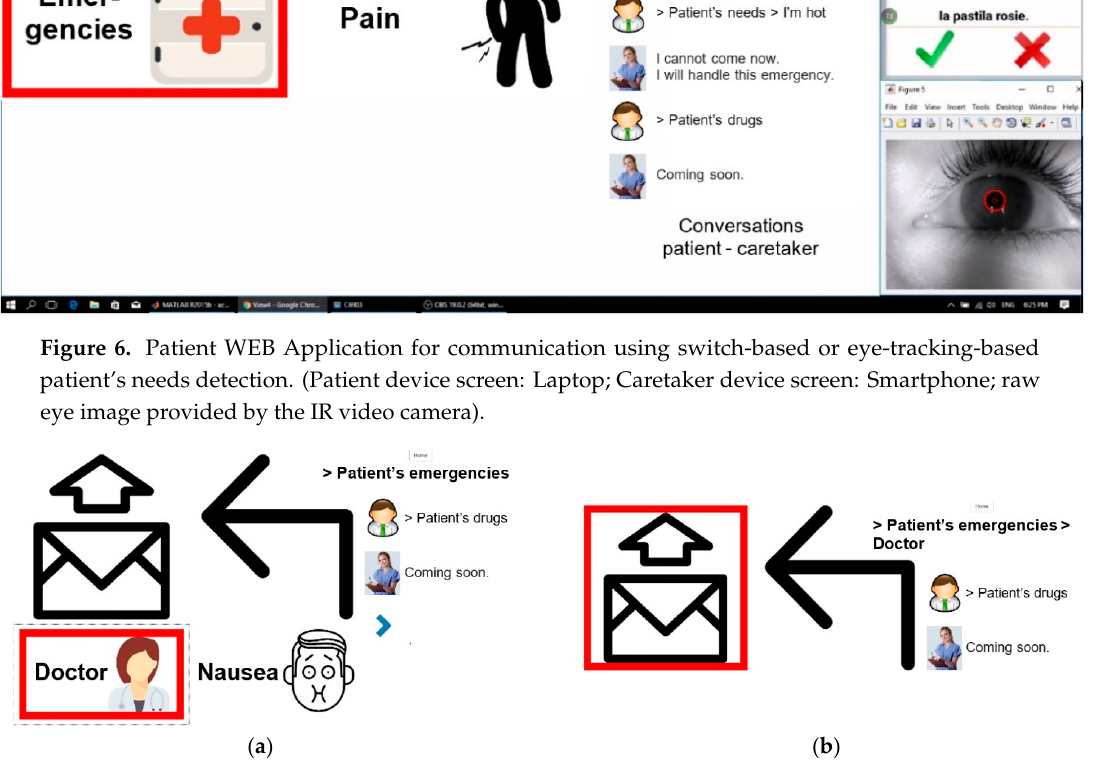
Figure 7. The process of sending a message to the caretaker: ( a ) ideograms belonging to the second hierarchical order after the first selection by the patient; ( b ) ideogram corresponding to the transmission of the wanted message (“Doctor”).